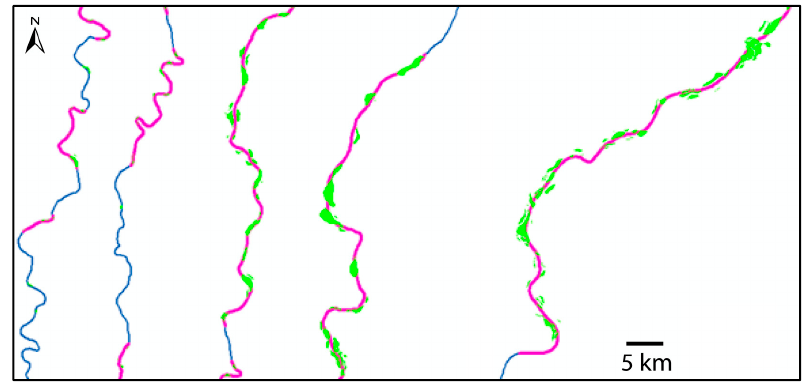
Figure 9. Results of the application of the binary, logical heuristic Holistic algorithm developed for the Magdalena River, as applied to the attribute “presence of islands”. Several consecutive stretches are presented (the river flows from bottom-left to top-right). The small green polygons are the original islands (then transformed into a 0 ÷ 1 indicator in the discretized VB, not shown here); the resulting linear attributes along the active bed axis (centerline) takes the pink color, with a thicker line, when the holistic indicator of presence of islands is “yes” and the blue, thinner line, when it is “no”. The significant length adopted is Ls = 5 km, shown at the bottom right, as the prevailing river width is W = 500 m (therefore, K = Ls / d = 10, as we assumed d =